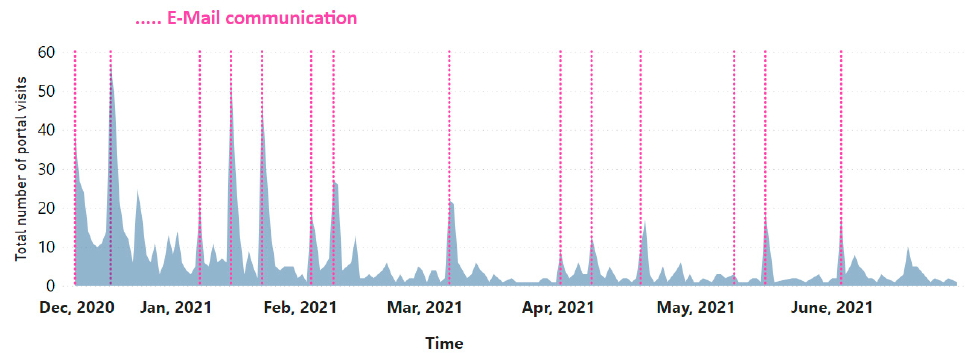
Figure 11. Activity on the portal (number of visits) compared to dates consumers received an email.